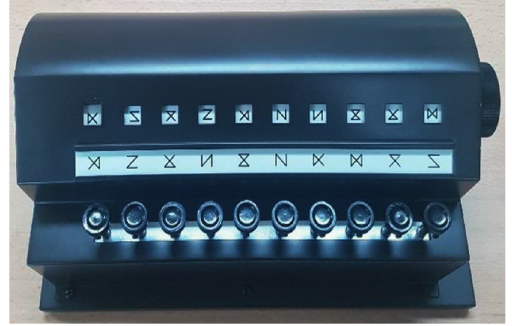
Figure 4: Attention measuring device.